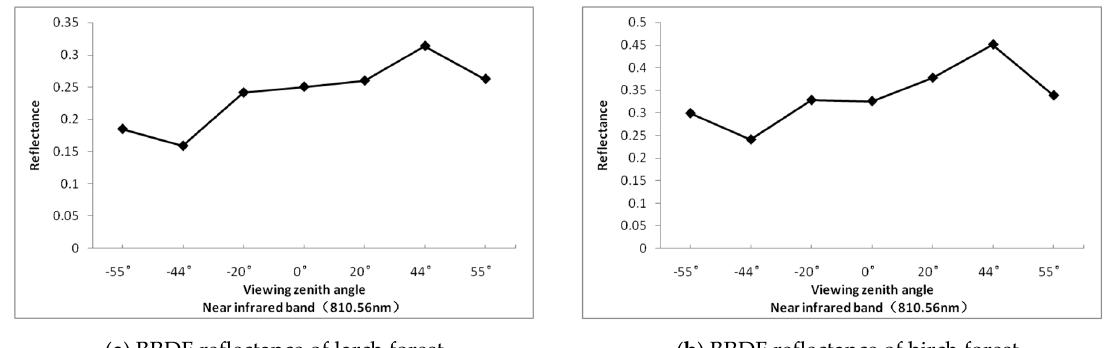
Figure 9. BRDF reflectance of typical forest types ( a , b ) in the Greater Xing’an Mountains, Northeast